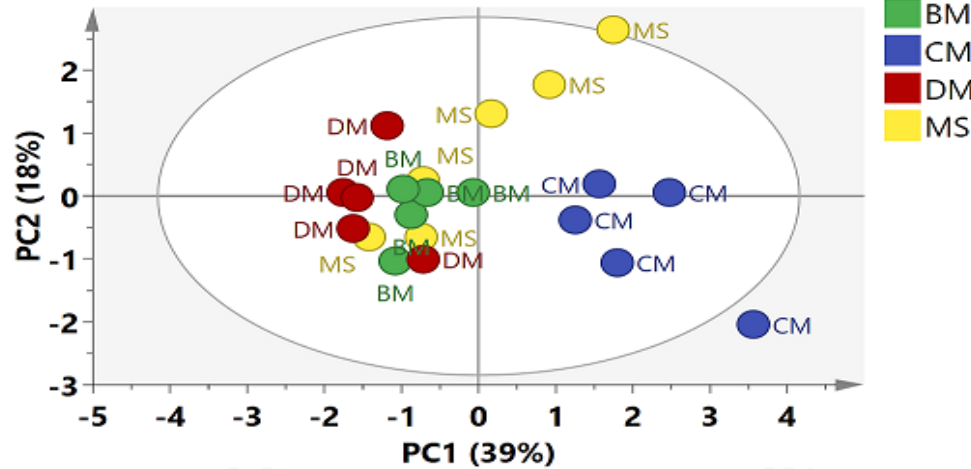
Figure 2. Score plot (PC1 vs. PC2) of PCA based on the whole range of 1 H-NMR signals ( δ 0.5– δ 10.0) of CM = Chicken; MS = Chevon; BM = Beef; DM = Donkey.